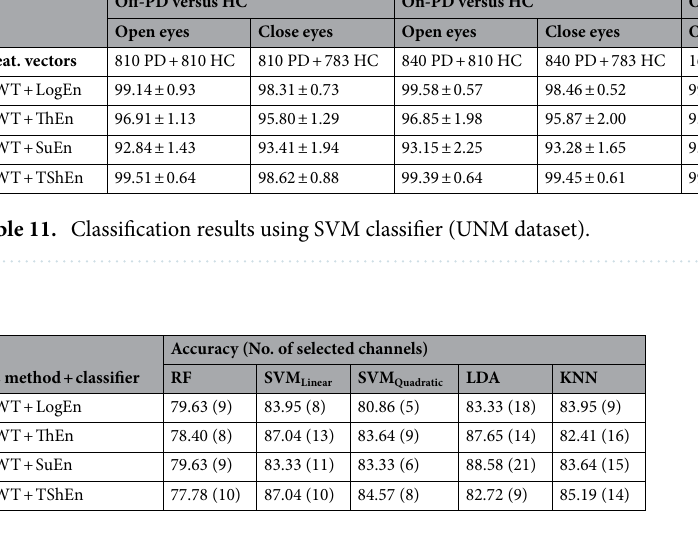
Table 12. Classification accuracy for off-PD versus HC based on leave one subject out CV technique.